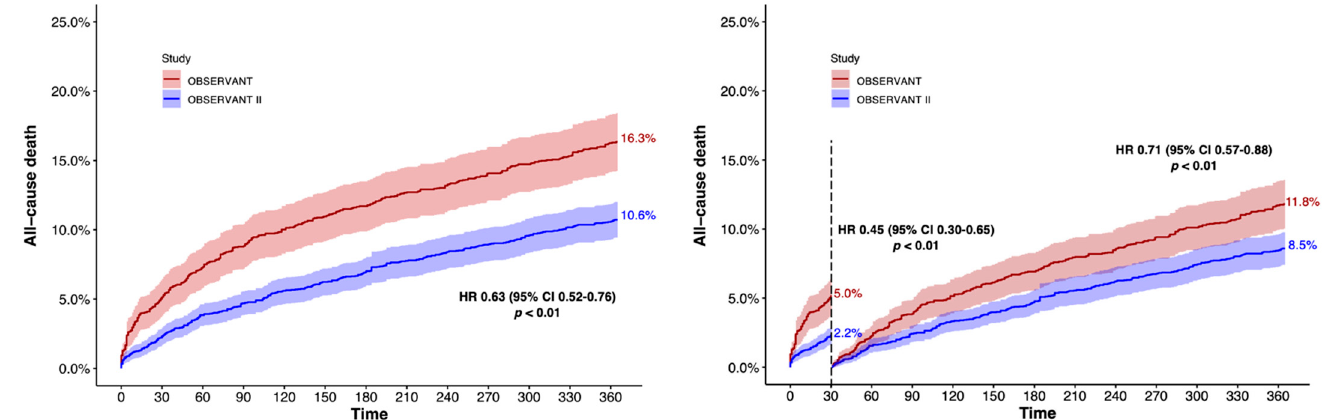
Figure 5. Adjusted 1-year Kaplan–Meier survival curve and landmark analysis for all-cause death. CI, confidence interval; HR, hazard ratio.